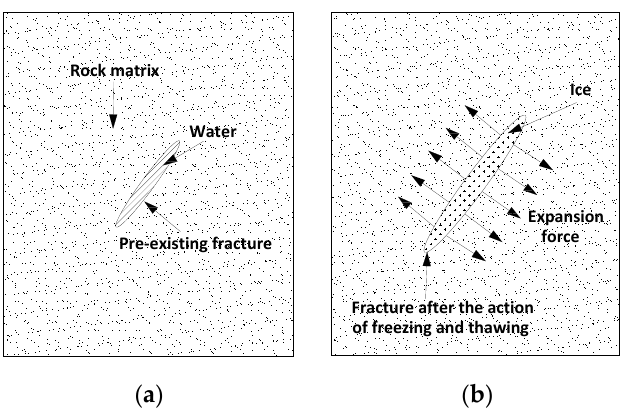
Figure 11. Schematic diagram of the freeze–thaw influence on microcrack propagation inside the rock: ( a ) initial crack inside the rock; ( b ) crack growth under the freeze–thaw influence.